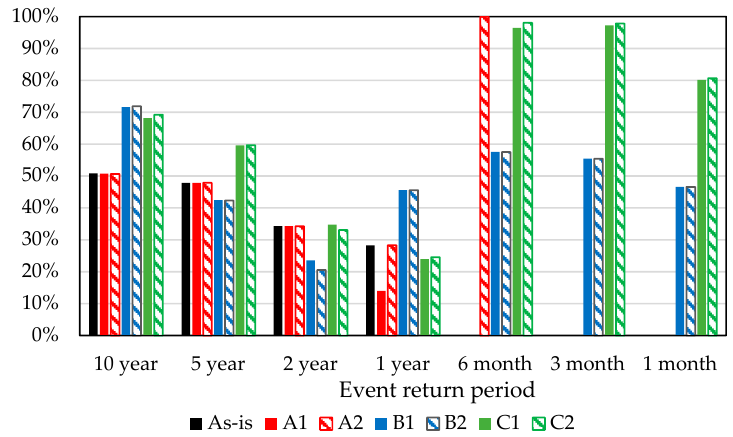
Figure 7. Comparison of the average reduction in peak flow currently provided by the existing pond system to when it is used for SWH over the 10-years of continuous modelling.